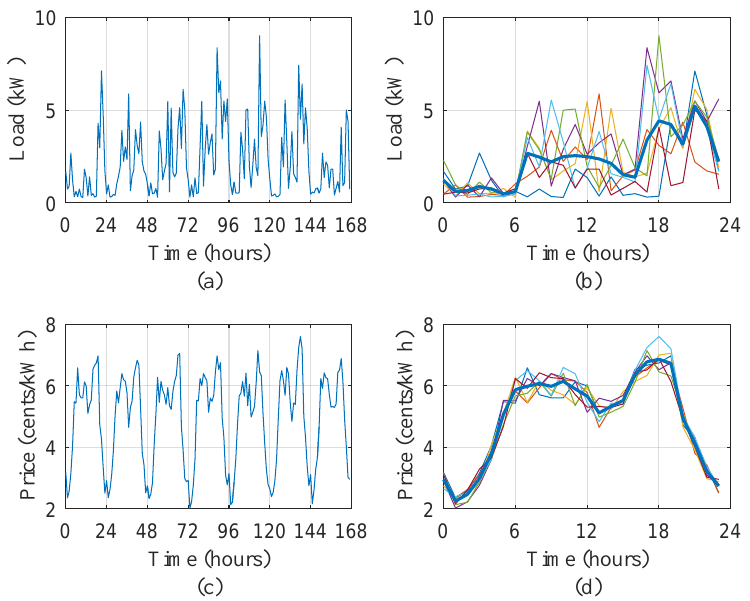
Figure 4. The weekly load demand and its average load curve. ( a ) Load demand of a smart building for one week. ( b ) Seven daily load demands and average load demand (bold line). ( c ) Electricity prices for one week. ( d ) Seven daily electricity prices and average electricity price (bold line).